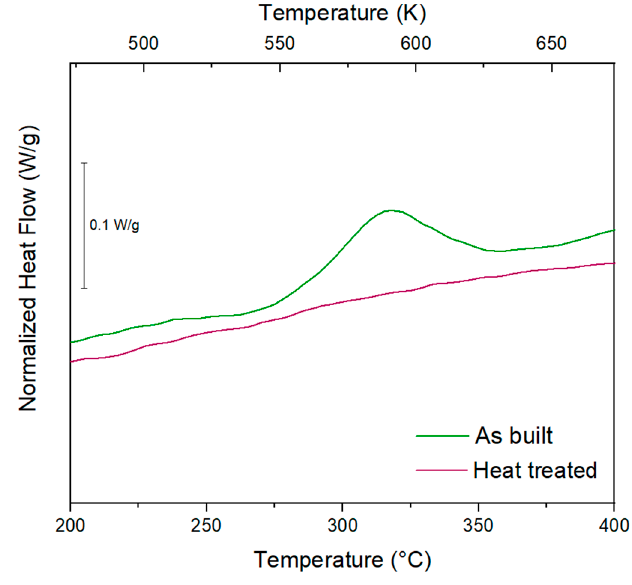
Figure 7. DSC signals of the as-built and heat-treated samples.